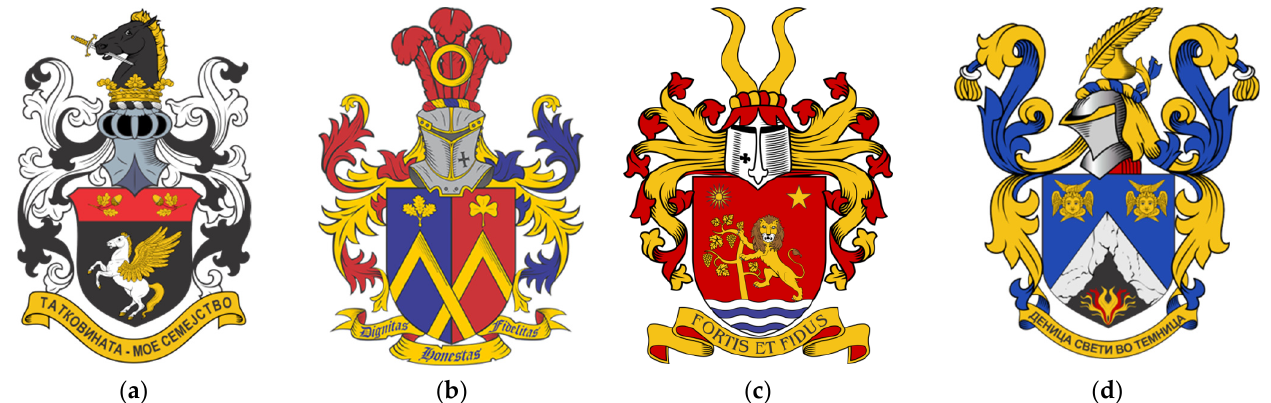
Figure 22. Samples of personal heraldry, coat of arms of ( a ) Ivan Nacevski; ( b ) Aleksandar Janchevski; ( c ) Bojan Kocevski, ( d ) Mojso Popovski.